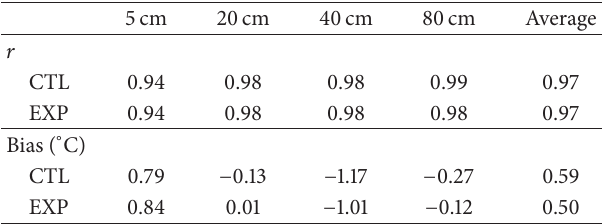
Table 5: Statistical results of simulated soil temperature from CTL and EXP at ZS site.